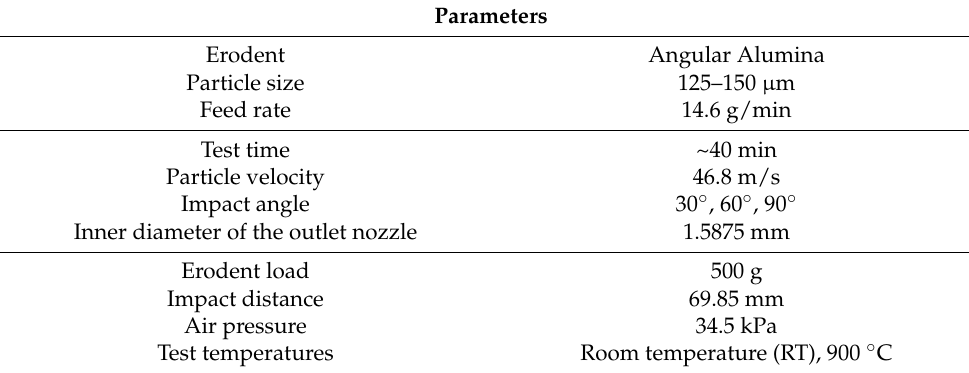
Figure 3. ( a ) High-temperature erosion test rig. ( b ) Alumina erodent particles. Table 2. Wear test parameters.